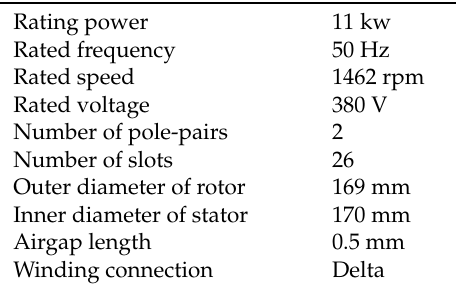
Table A1. The parameter of the induction